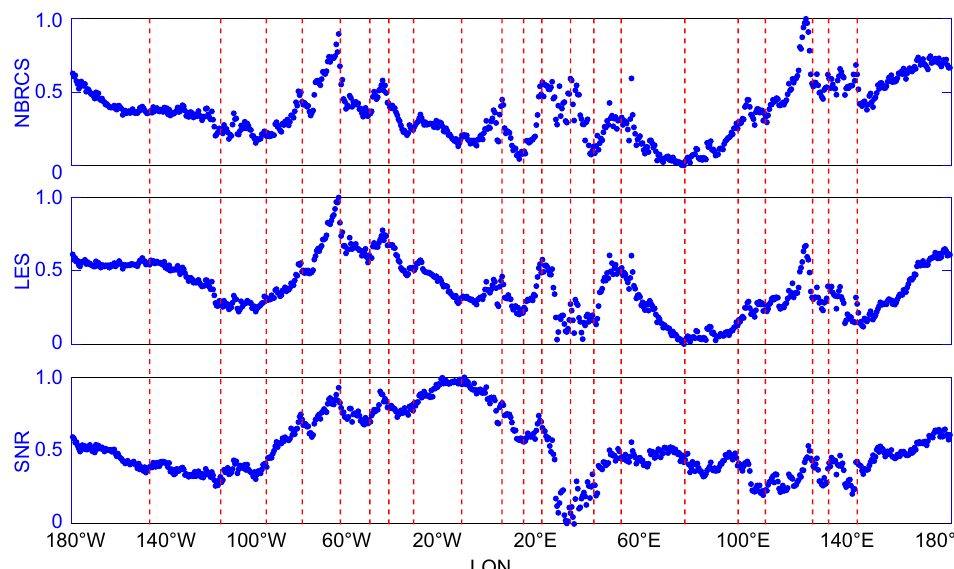
Fig. 6 Geographic partitioning based on the change of CYGNSS observables